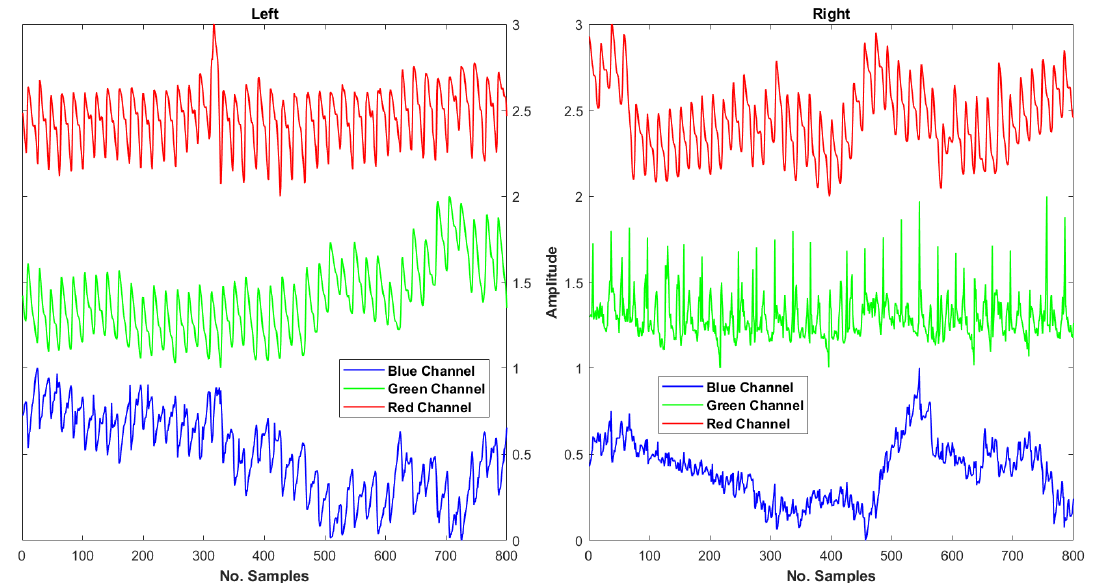
Figure 3. Representative PPG signal extracted from the (Red) channel, (Green) channel, and (Blue) channel of two video frames of varying quality. The extracted PPG on the left side signal was observed to be more reliable compared to the right side.